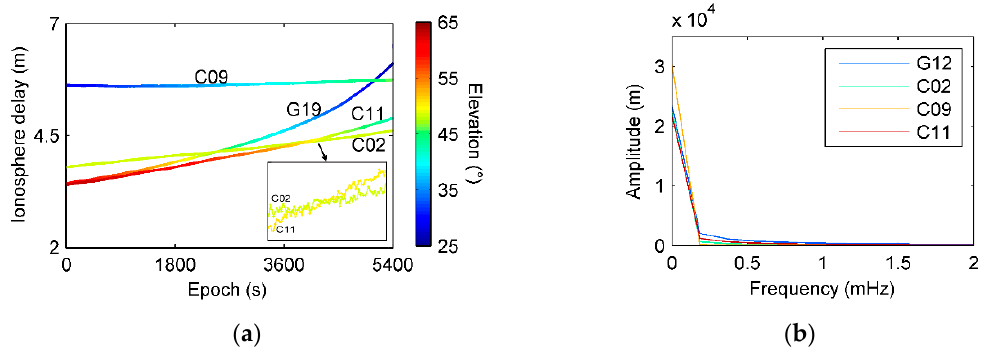
Figure 12. Examples of ionospheric delays and frequency spectrums. ( a ) Ionospheric delays extracted by dual frequency combinations. ( b ) Frequency spectrum of ionospheric delay using FFT.